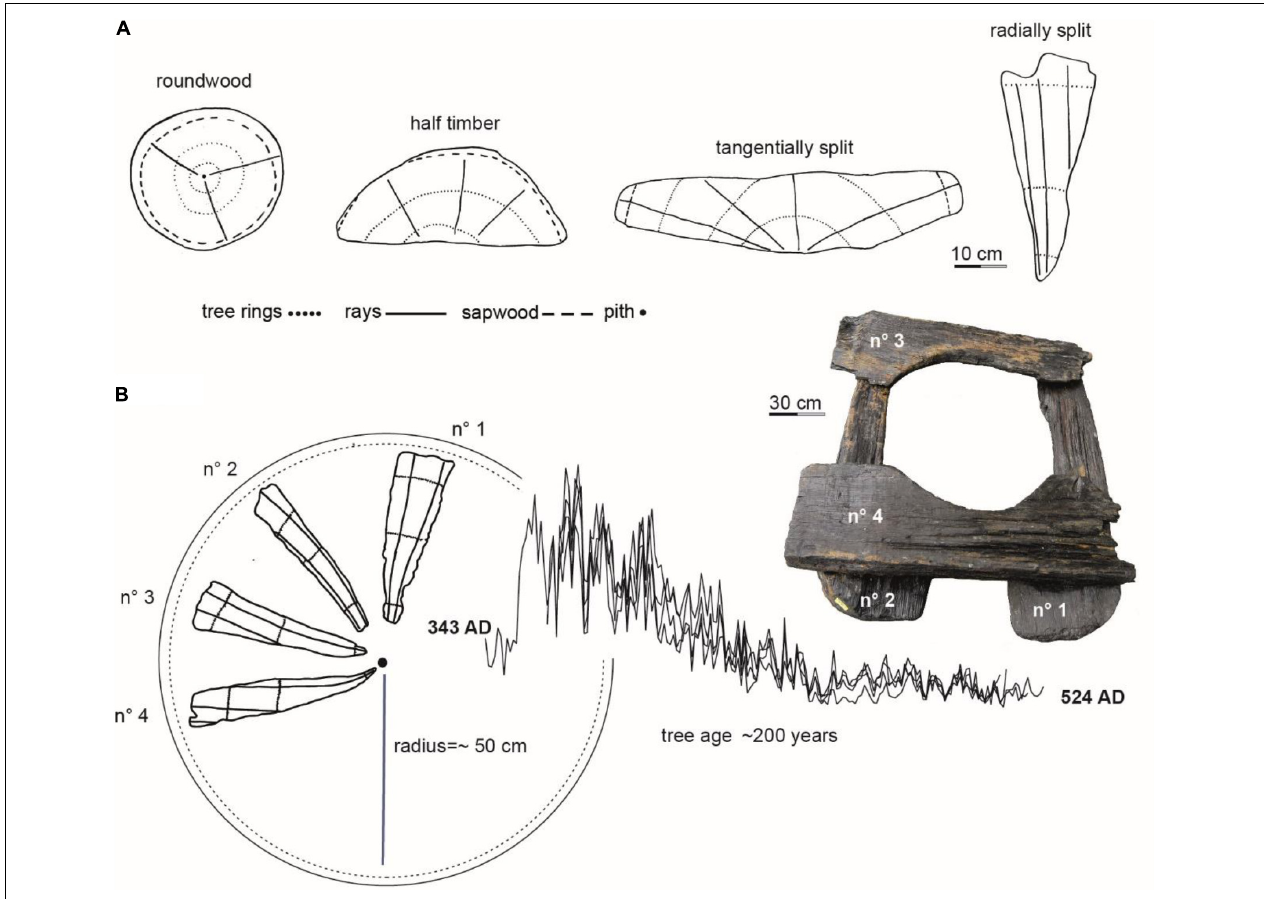
FIGURE 5 | Documentation of the used trees by (A) drawing the cross-sectional shape on a scale of 1:5 and (B) reconstruction of the origin and attribution to one individual tree trunk by using cross-sectional shapes and highly synchronous tree-ring growth patterns of the individual tree-ring